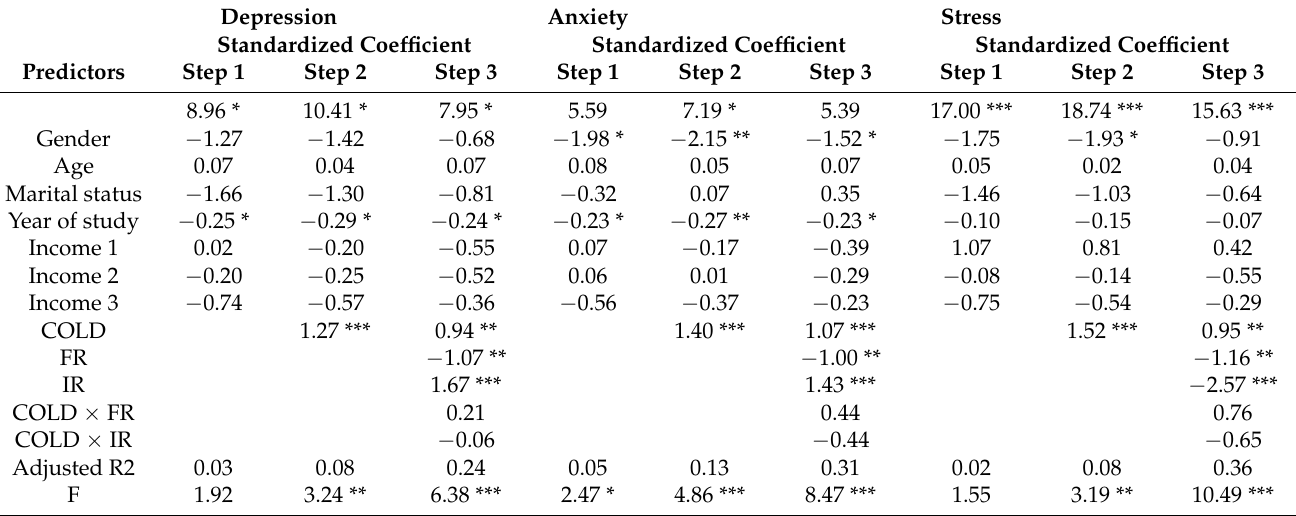
Table 4. Hierarchical regression analyses predicting mental health outcomes.